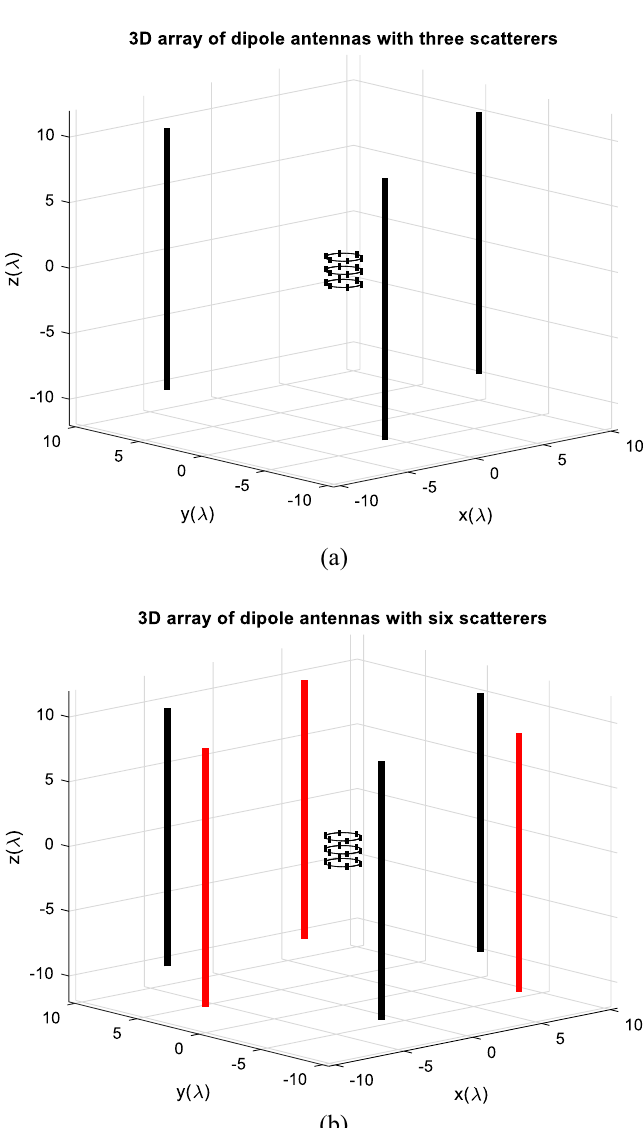
Fig. 11 Three-dimensional cylindrical array of half-wave dipole antennas in presence of a three large cylindrical scatterers, b six large cylindrical scatterers (three more scatterers are added with red